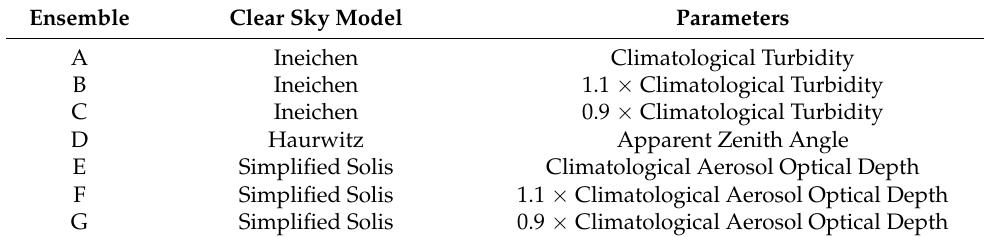
Table 2. Clear sky models used in generating the ensemble product.